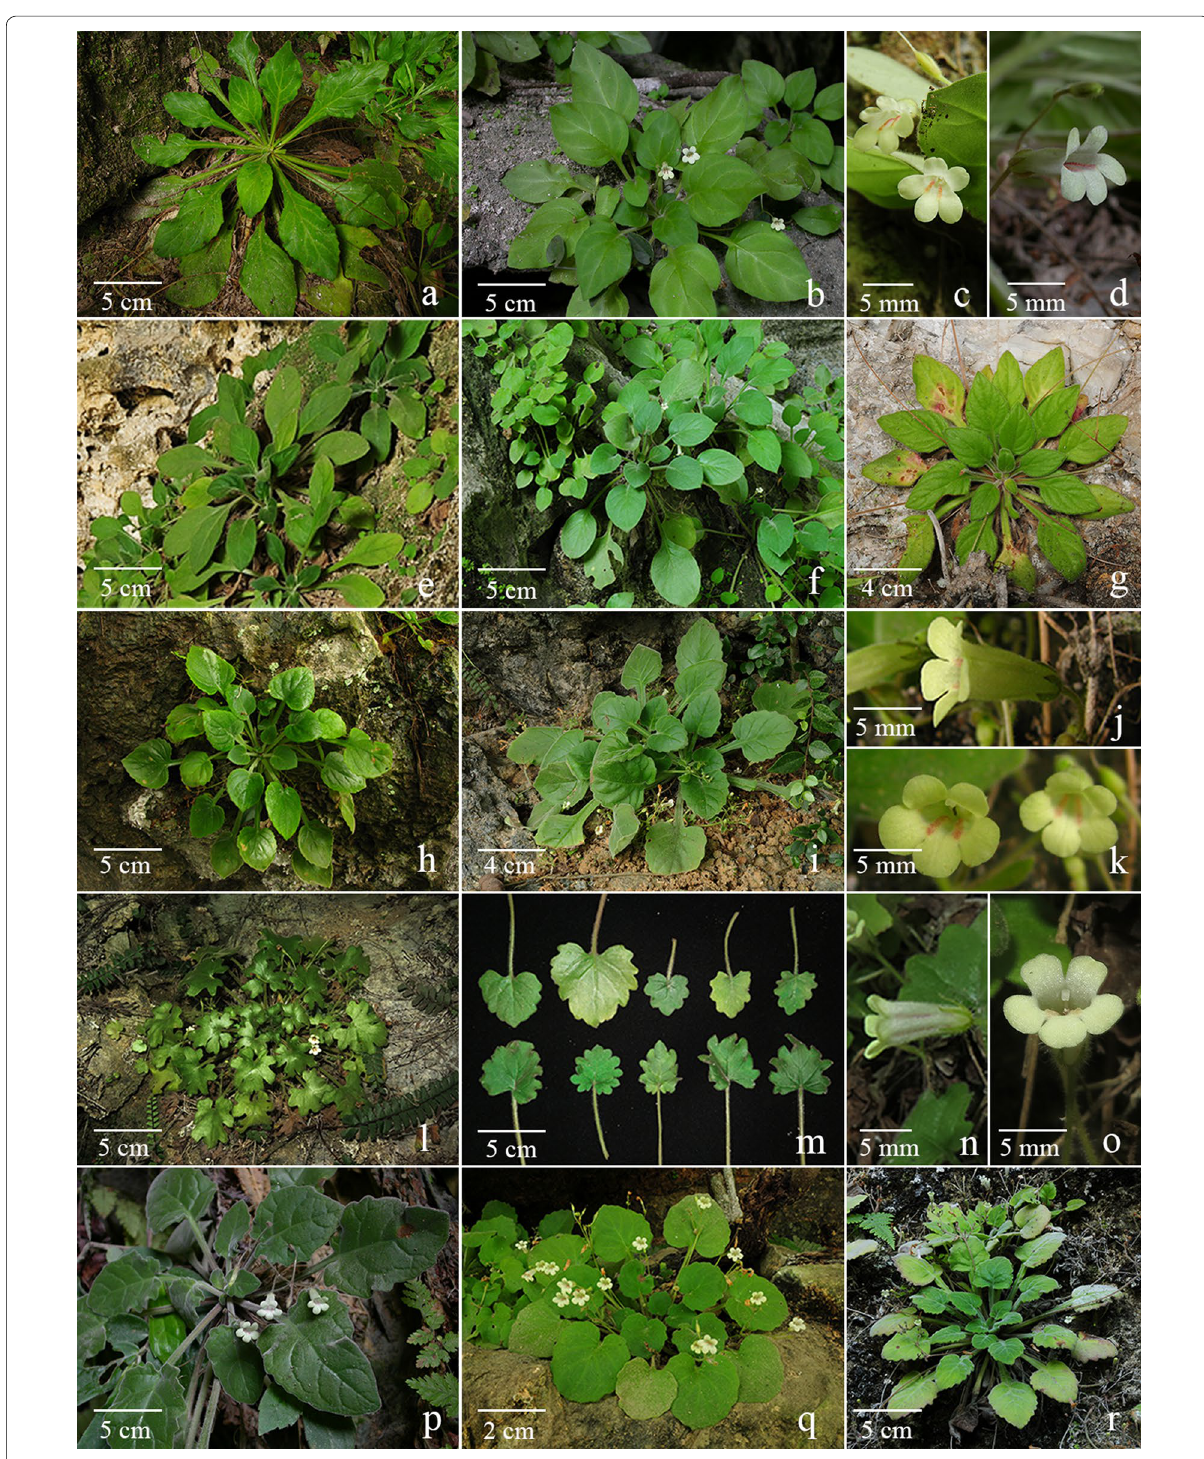
Fig. 2 Primulina repanda ( a – g ), P. cordifolia ( h – k , p – r ), and P. huangii ( l – o ). a – d plants from the type locality of Chiritopsis repanda W.T.Wang ( Chung 1821 ), a , b habit, c flowers (face view), d flower (side view); e plants from Liujiang ( Peng 22921 ); f plants from Rongshui ( Chung 1815 ); g a plant from Tian’e ( Chung et al . 1823 ); h – k plants from the type locality of C. cordifolia W.T.Wang ( Chung 1817 ), h , i habit, j flowers (side view), k flowers (face view); l – o plants from type locality of P. huangii F.Wen & Z.B.Xin, l habit, m variation in leaf shapes, n flower (side view), o flower (face view); p a plant from Bama ( Chung et al . 1828 ); q plants from plants from Rong’an ( Chung et al . 1808 ); r a plant from Donglan ( Chung et al . 1826